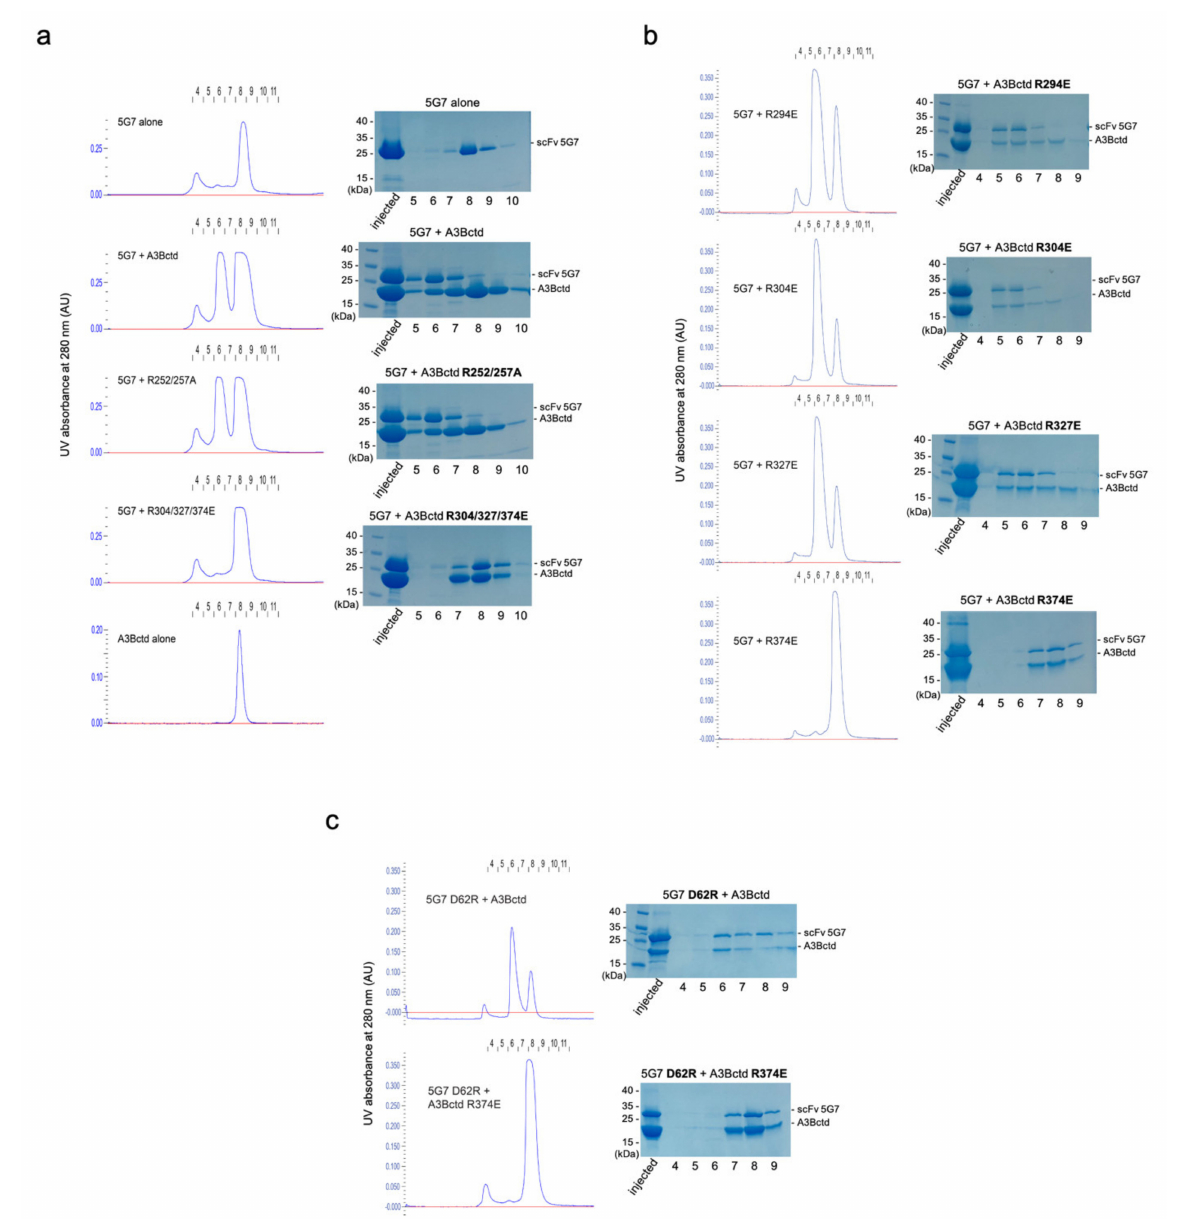
Figure 6. A3Bctd R374 is essential in 5G7-binding. ( a ) Complex formation by A3Bctd variants with substitutions of multiple Arg residues. The chromatograms are shown on the left, and SDS-PAGE analyses of the collected fractions are shown on the right. ( b ) Complex formation by A3Bctd variants with individual Arg substitutions. The results show that A3Bctd Arg374 is required for the binding to 5G7 while other Arg residues are not. ( c ) Complex formation between 5G7 D62R and A3Bctd or A3Bctd-R374E, showing that Asp62 is not important in the binding of